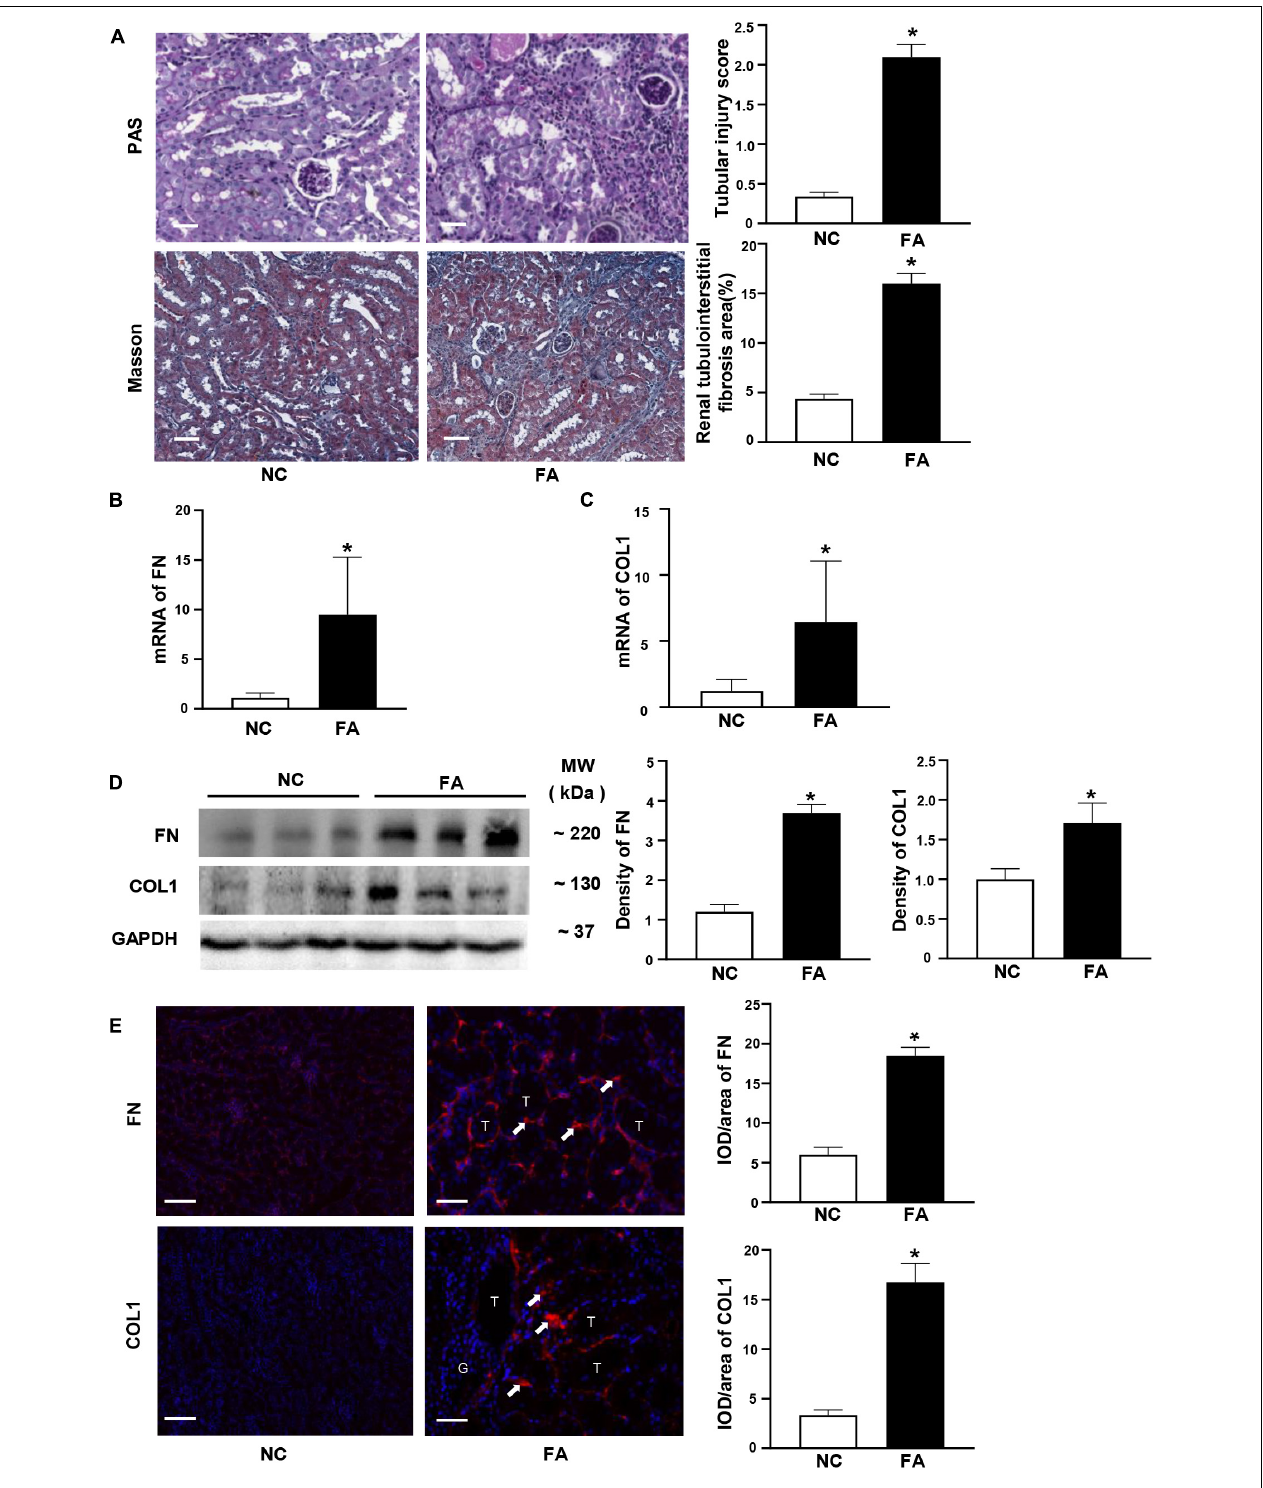
FIGURE 1 | Typical renal fibrosis and the expression of fibronectin (FN)/collagen 1 (COL1) in folic acid (FA)-induced renal tubulointerstitial fibrosis in mice. (A) Periodic acid–Schiff (PAS) and Masson staining and semi-quantitative analysis. (B,C) mRNA levels of FN and COL1 on quantitative PCR (qPCR). (D) Proteins levels of FN and COL1 on immunoblotting and semi-quantitative analysis. (E) Expression of FN and COL1 (arrow) on immunofluorescent staining and semi-quantitative analysis. n = 6 in each group, * p < 0.05, FA vs. NC, magnification 200 × , bar scale: 50 µ m. FA, folic acid; RIF, renal tubulointerstitial fibrosis.